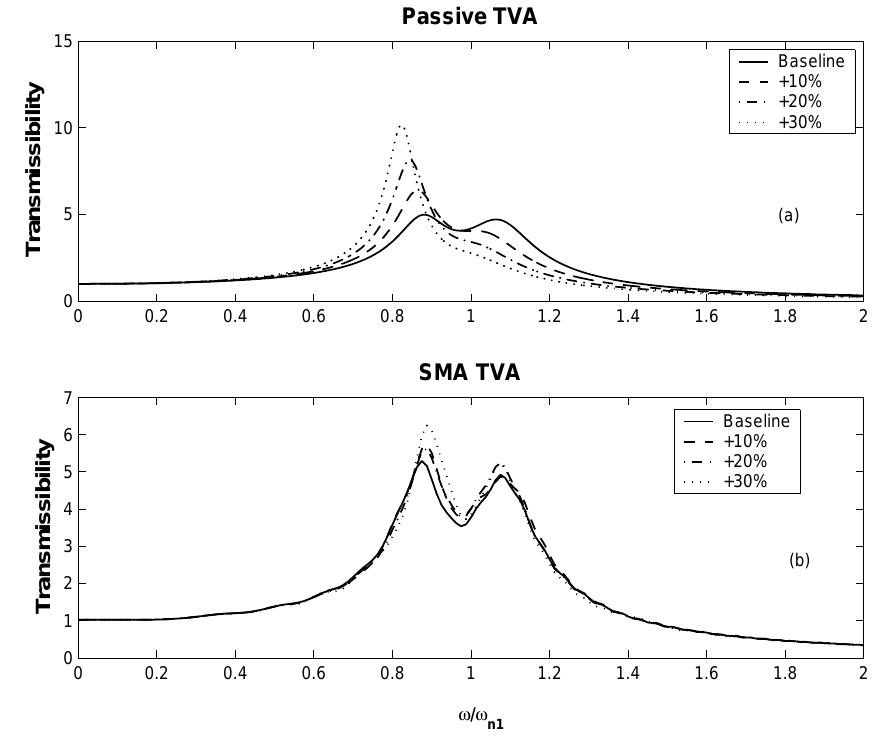
Fig. 11. Peak transmissibility variation, increasing the primary mass by 30%: (a) passive TVA (b) SMA